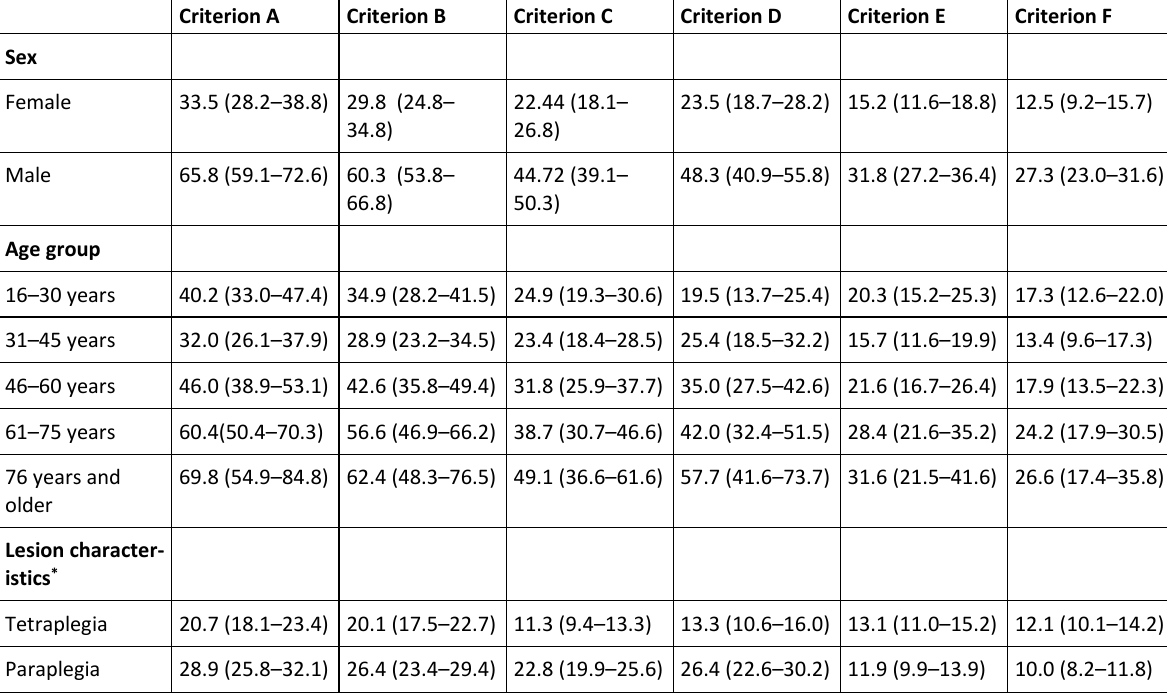
Table 3: Annually estimated incidence rates per million population using administrative data, according to case identification